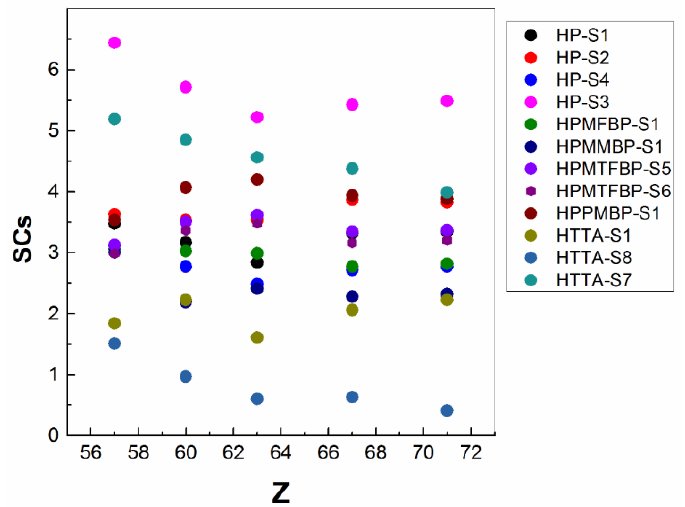
Figure 14. SCs vs. Z for several solvent mixtures.